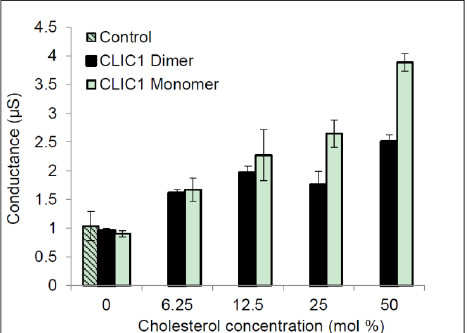
Figure 1. Conductance of CLIC1 in tBLMs containing varying amounts of cholesterol. 20 µg of CLIC1 oxidised dimer was pre-incubated with 2 mM H 2 O 2 ; 20 µg of CLIC1 reduced monomer was pre- incubated with 0.5 mM TCEP in 100 µL of HEPES/KCl buffer (pH 6.5) prior to adding to tethered bilayer membranes containing 0, 6.25, 12.5, 25 and 50 mol % cholesterol concentrations. Control is membrane with 0 mol % cholesterol containing 100 µL HEPES/KCl buffer (pH 6.5) with no protein added. The error bars represent the standard error of three independent impedance spectroscopy conductance measurements ( n = 3).